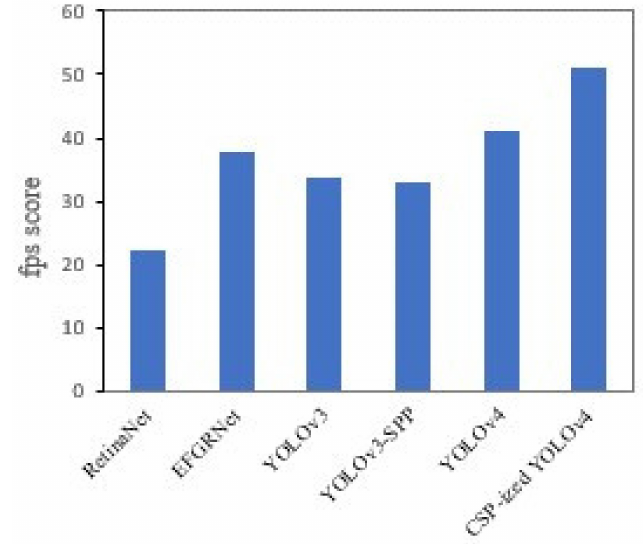
Figure 11. The best speed trade-off in terms of fps